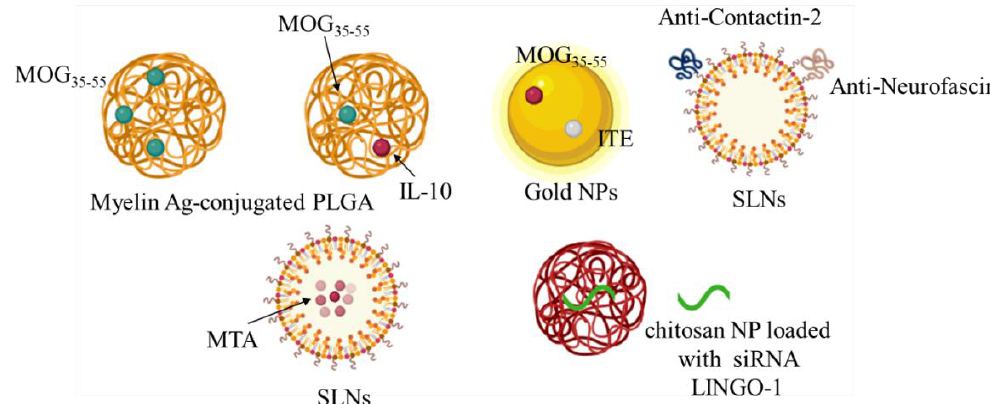
Figure 4. The picture summarizes the results of the therapeutic potential of different types of with different molecules, anti-inflammatory molecules and/or myelin antigens (immunotolerance effect), or functionalized nanoparticles (NPs) loaded with different molecules, anti-inflammatory molecules and/or my- elin antigens (immunotolerance effect), or functionalized (to increase a specific target) for a (to increase a specific target) for a potential therapeutic approach against potential therapeutic approach against MS.